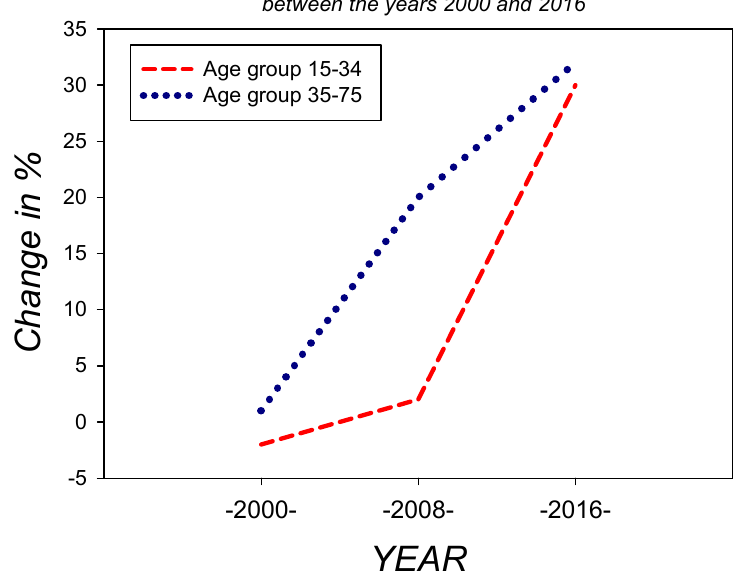
Figure 5. Estimates for suicide rates in the USA, which has an internet penetration index of 92% of the global population, between the years 2000 and 2016. Estimates are expressed herein as the % of change (increase / decrease) per annum, showing an alarmingly steep increase for the age group of 15 to 34 year old individuals. The key data shown here have been replotted on the basis of a report published by the US Naval Institute in 2018 [76], which points towards a link between the increase shown here and digital addiction, especially in younger individuals. The hypothesis is consistent with data from scientific studies, summarized above, showing a tight connection between internet addiction, insomnia, and depression in young males and females.